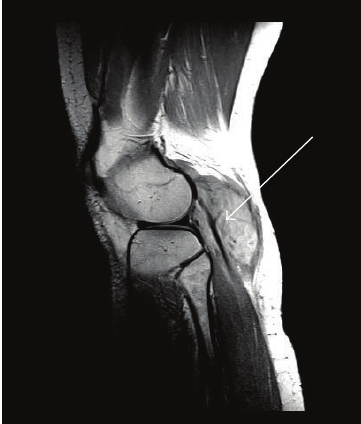
Figure 1: MRI scan, sagittal view.